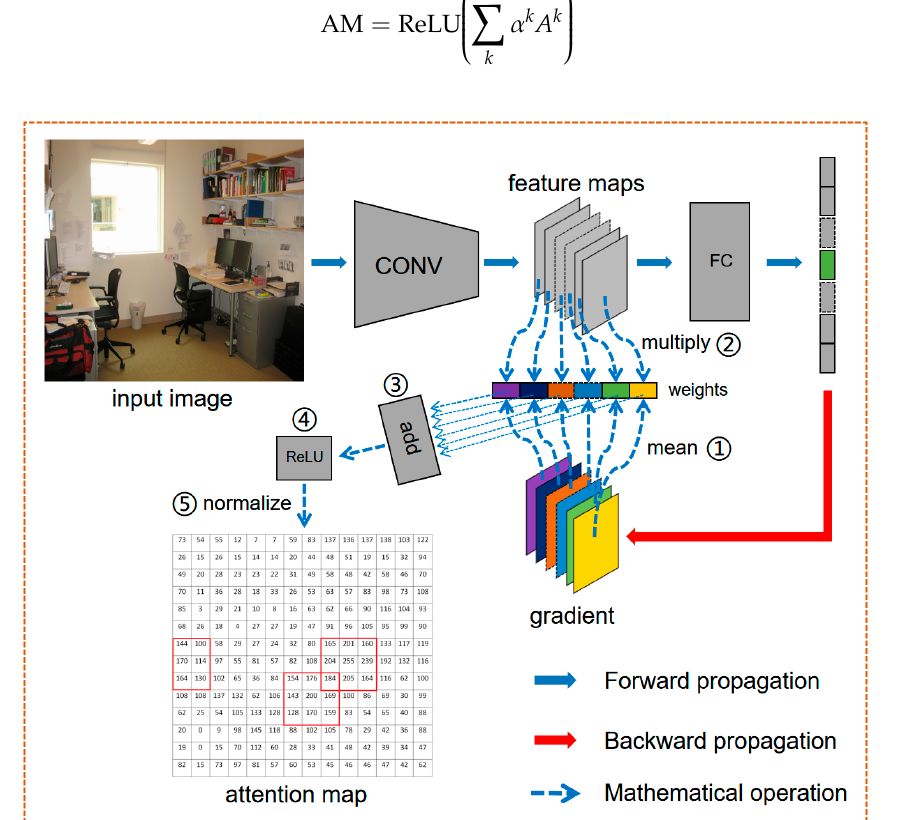
Figure 4. The pipeline of WS-AM. We use weakly supervised information to generate the attention map for each image.